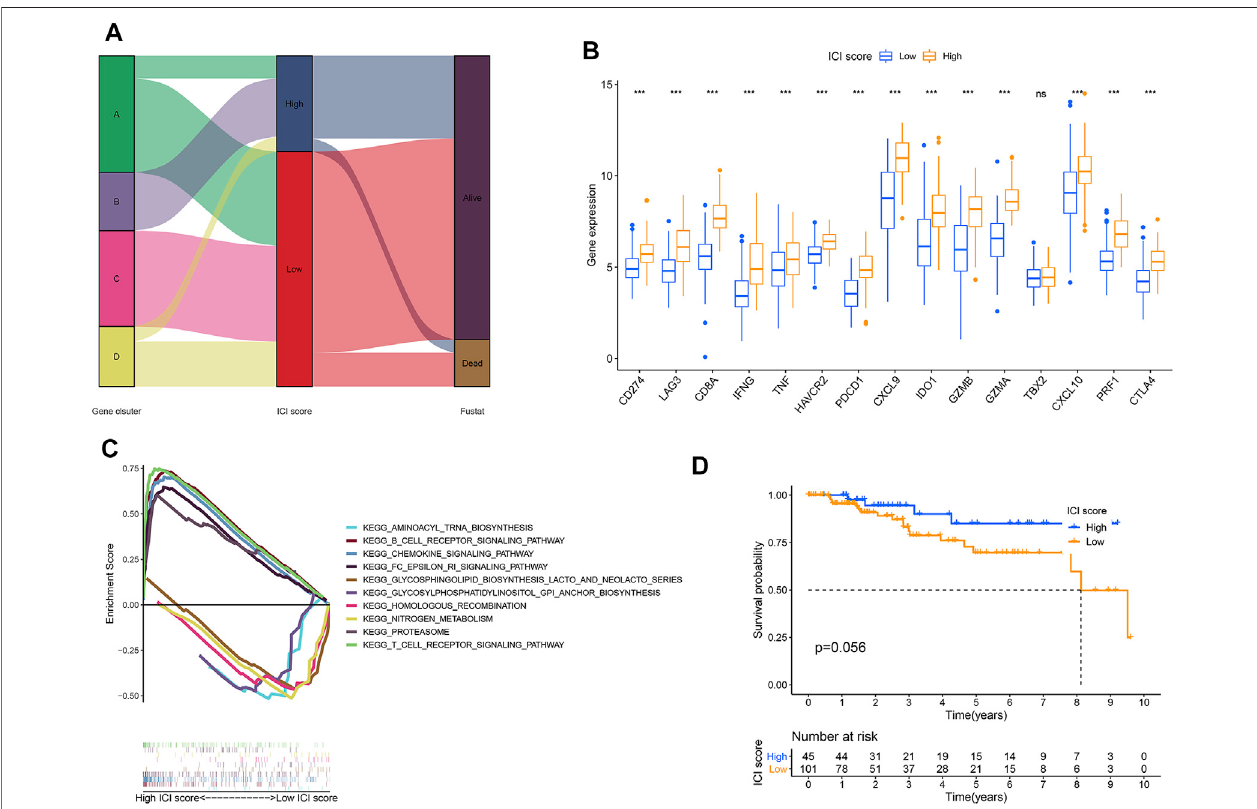
FIGURE 3 | TNBC high- or low-score groups according to ICI scores. (A) Alluvial diagram of ICI gene cluster distribution in the four-gene groups with distinct ICI scores and survival states. (B) Expressions of immune checkpoint and immune activation relevant genes between two groups. (C) GSEA analysis in high- and low-ICI score groups. (D) KMA for two groups in the TCGA-TNBC cohort. p =